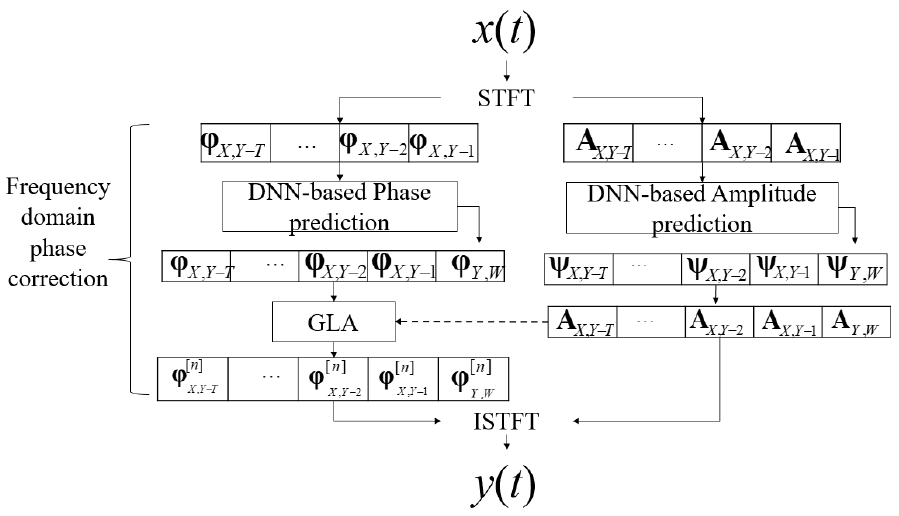
Figure 8. Illustration of the frequency domain PLC